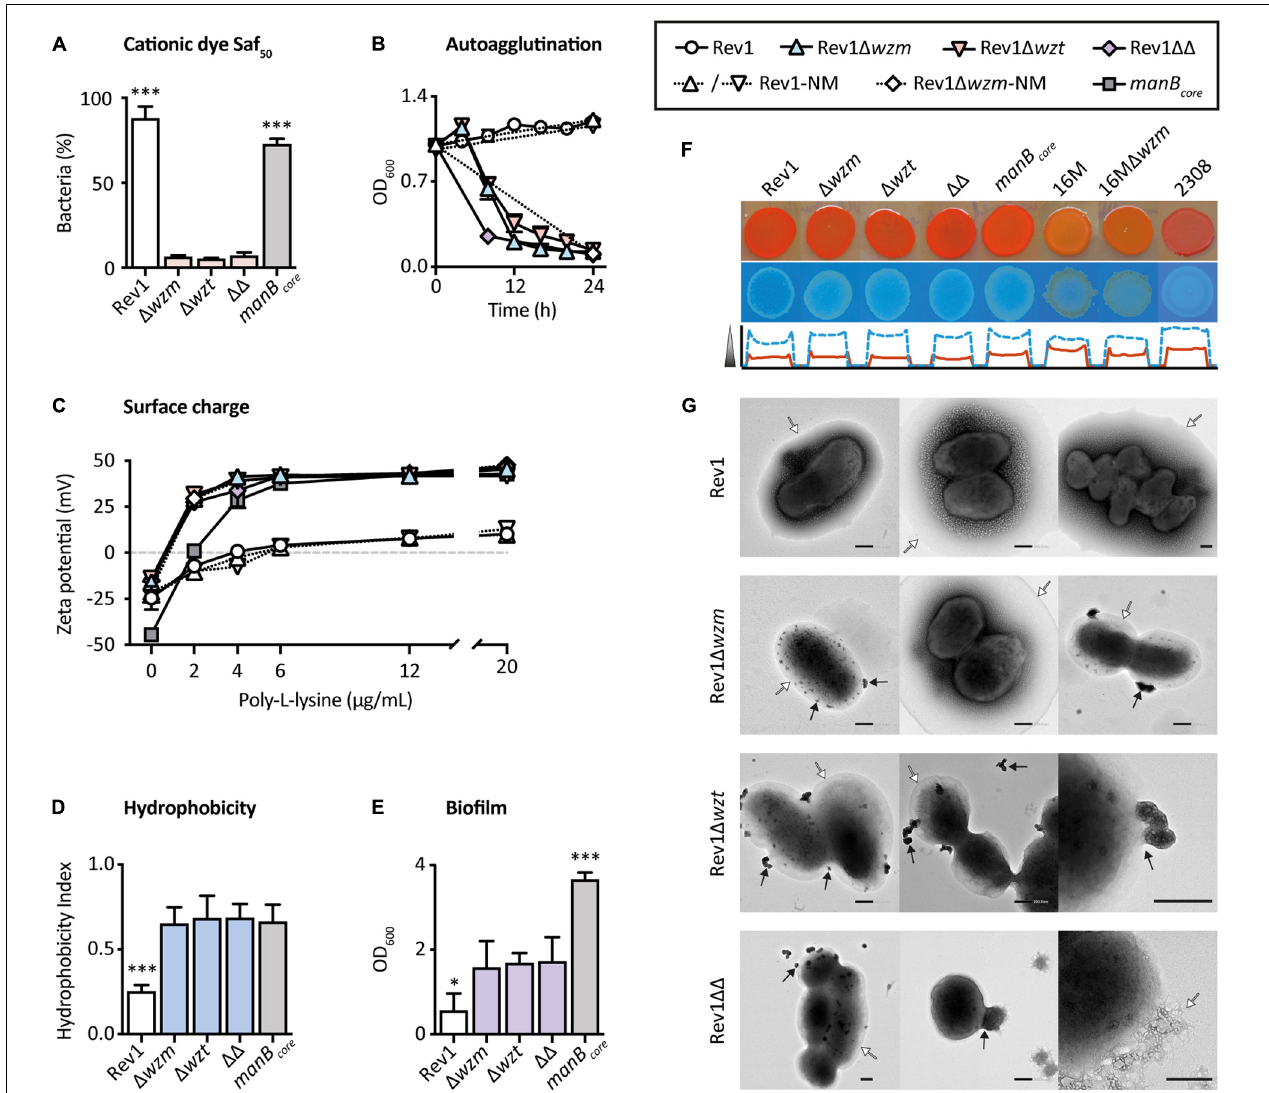
FIGURE 3 | Outer membrane properties of wzm / wzt mutants are modified in comparison with Rev1. (A) Inhibition by the cationic dye safranin O at 50 µ g/ml (Saf 50 ) in BAB-S and 10% CO 2 represented as surviving bacteria (%; mean ± SD; n = 3) vs. the standard growth condition. (B) Autoagglutination in static culture determined by spectrophotometry (mean ± SD; n = 2; representative result). (C) Surface charge measured by Zeta-potential (mean ± SD) in absence ( n = 4) or presence ( n = 2) of poly-L-lysine. (D) Hydrophobicity based on differential partitioning in aqueous-hydrocarbon solution (mean ± SD; n = 3). (E) Biofilm formation quantified by crystal violet staining (mean ± SD; n = 3). (F) EPS analysis by the intensity of Congo Red (upper row; red line) or Calcofluor (the low row; the discontinuous blue line). (G) Representative TEM images with negative stain in which EPS and OMVs are indicated by white and black arrows, respectively; scale bars = 200 nm. Fisher’s LSD test; ∗∗∗ p ≤ 0.001, ∗ p ≤ 0.05 vs. the other